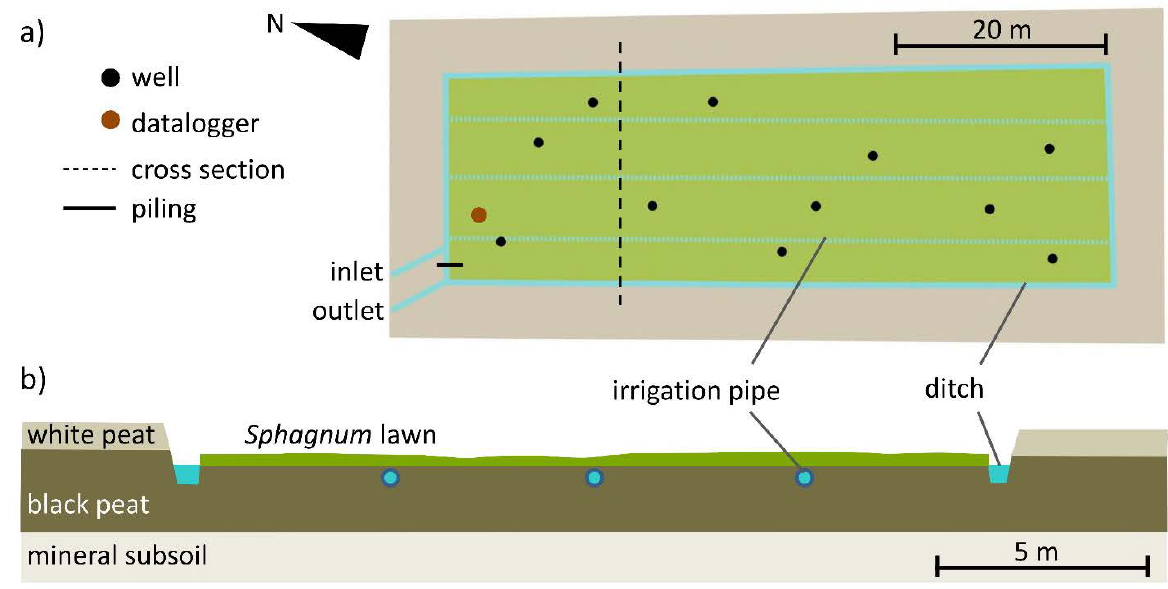
Figure 2. a) Schematic plan view and b) cross-section of the Ramsloh Sphagnum farming study site at the start of the experiment (after Kamermann & Blankenburg 2008).